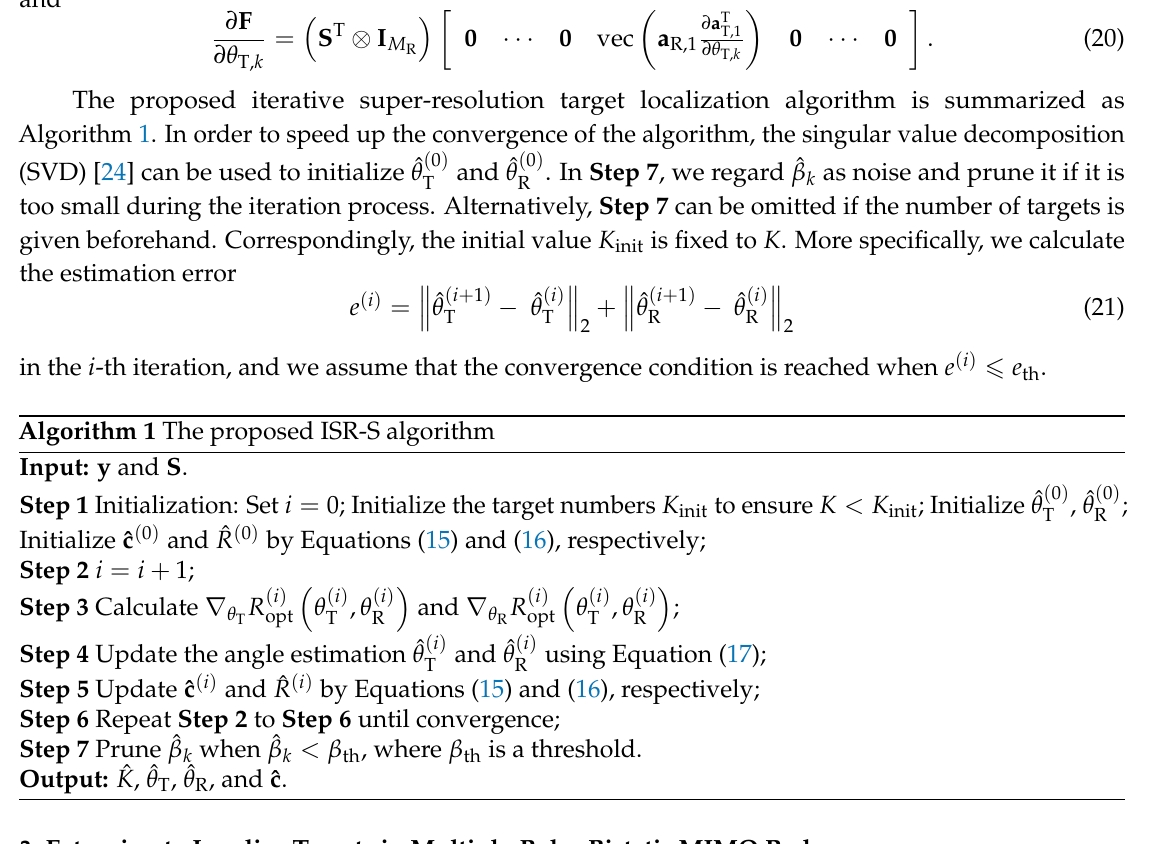
( 0 ) ( 0 ) and ˆ θ . In Step 7 , we regard ˆ β k as noise and prune it if it is T R